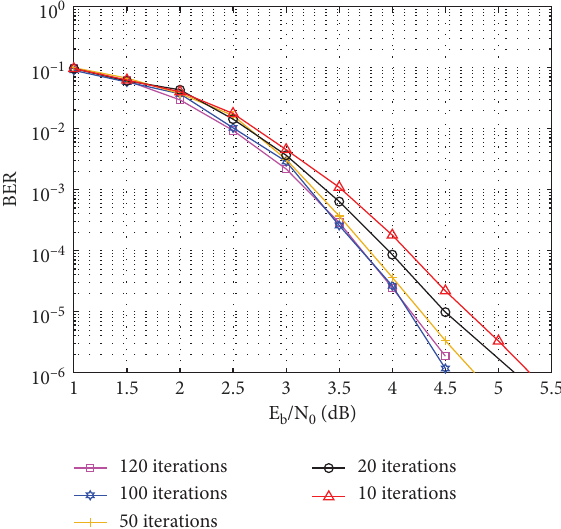
Figure 10: BER performance of MSA decoding for LDPC code under diferent maximum number of iterations. n � 264 and R � 2/3.